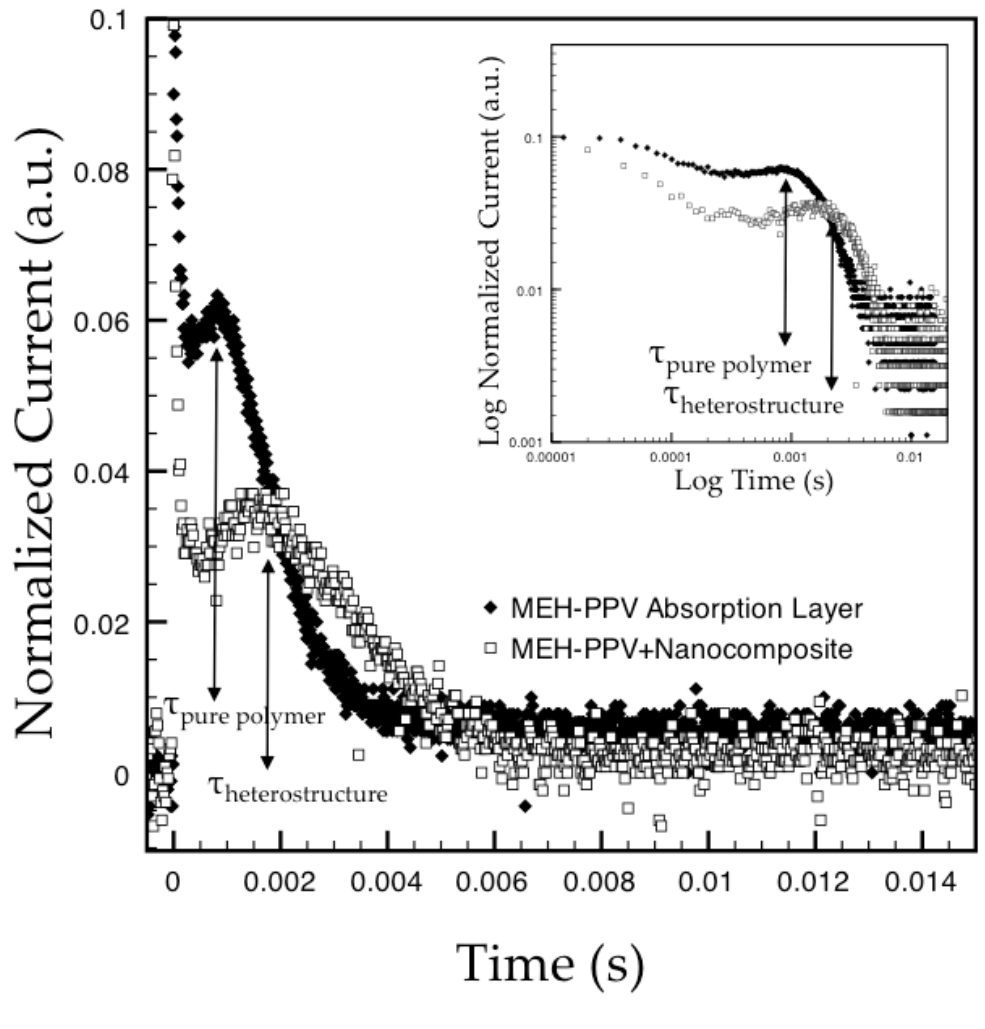
Figure 2. TOF transients for the entire 80:20 MEH-PPV:CdSe CQD (CdSe colloidal quantum dot) heterostructure and for the pure polymer laser absorption layer at 30 °C and an applied field of 2.6 × 10 5